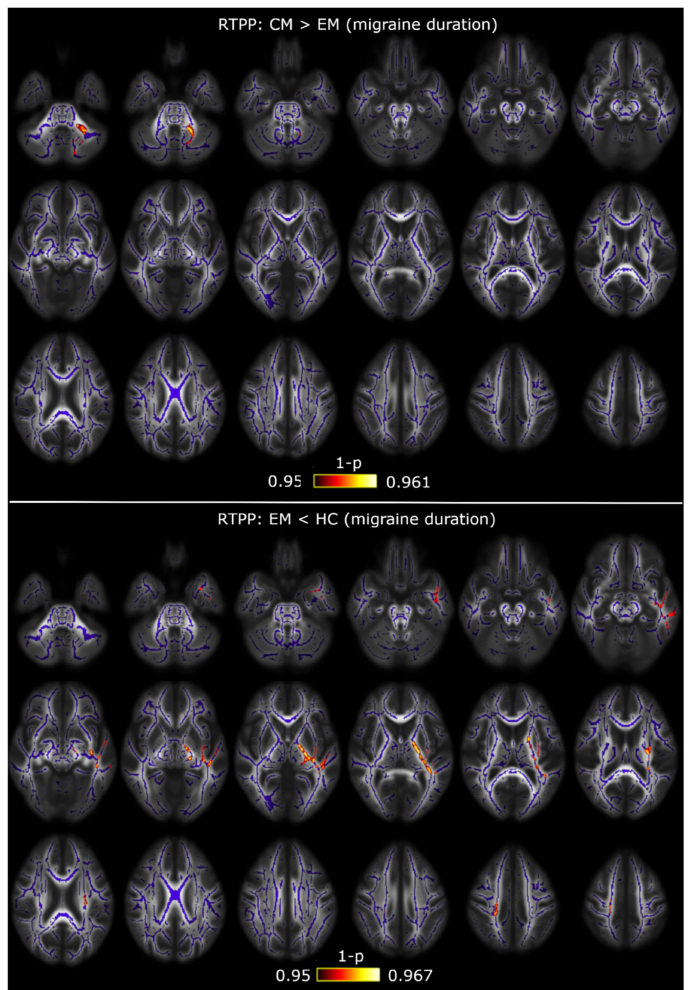
Figure A1. RTPP alterations between CM and EM including the duration of the migraine as a covariate. TBSS showed increased RTPP values in CM with respect to EM in the middle cerebellar peduncle (top) and decreased RTPP values in EM compared to HC throughout the left hemisphere and the corona radiata (bottom). The white matter skeleton is shown in blue, and voxels with the lowest p -values in red-yellow. The color bar shows the 1- p -values (FWE-corrected). Table A5. White matter regions from the ICBM-DTI-81 White Matter Atlas for which significant decreased RTAP values were found in CM compared to HC including the time from onset of CM as a covariate. Minimum p -Value Volume MNI Peak Coordinate White Matter Region (FWE-Corrected) (mm 3 ) (mm), (x,y,z) Superior longitudinal fasciculus R 0.046 179 (39, − 9,26) External capsule R 0.044 244 (33, − 14, − 3) Retrolenticular part of internal 0.045 157 (34, − 21, − 2) capsule R Sagittal stratum R 0.045 194 (39, − 18, − 12) FWE = Family-wise error; L = left; R = right. The column volume represents the volume from the atlas region with significant results. No regions with a volume equal or lower than 30 mm 3 were included in this